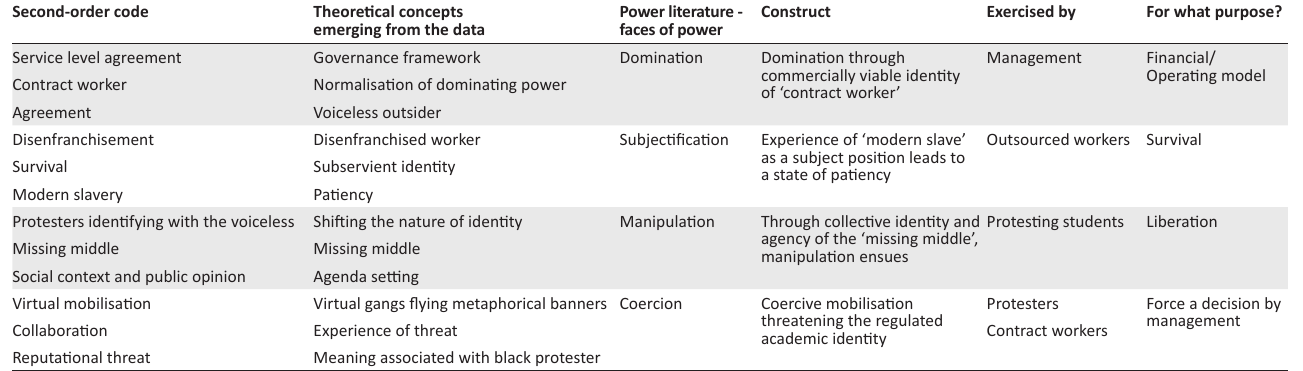
TABLE 2: Data structure of emerging themes relating to how power